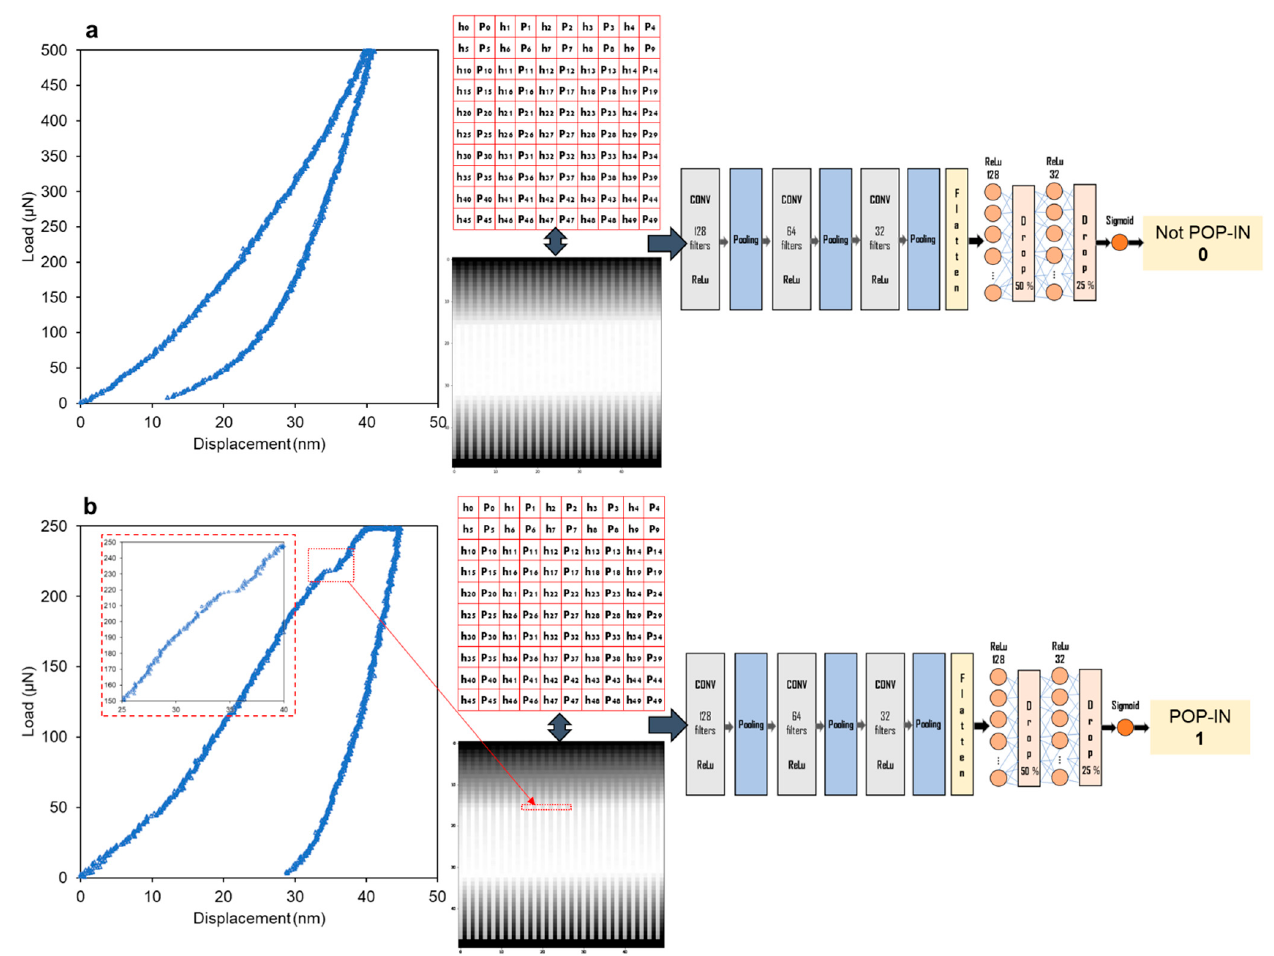
Figure 5. CNN implementation workflow: load–displacement curves ( a . typical loading path, b . pop-in) are converted into matrices (“images” in grayscale) which are the inputs to pass to the CNN model, which give an output equal to 0 for no pop-in and 1 for pop-in events. The numerical matrices are just for illustration and do not represent the model’s 50 × 50 matrices used as input.